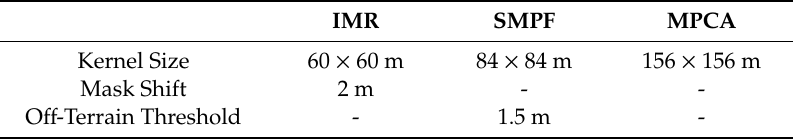
Table 4. Final selection of algorithm